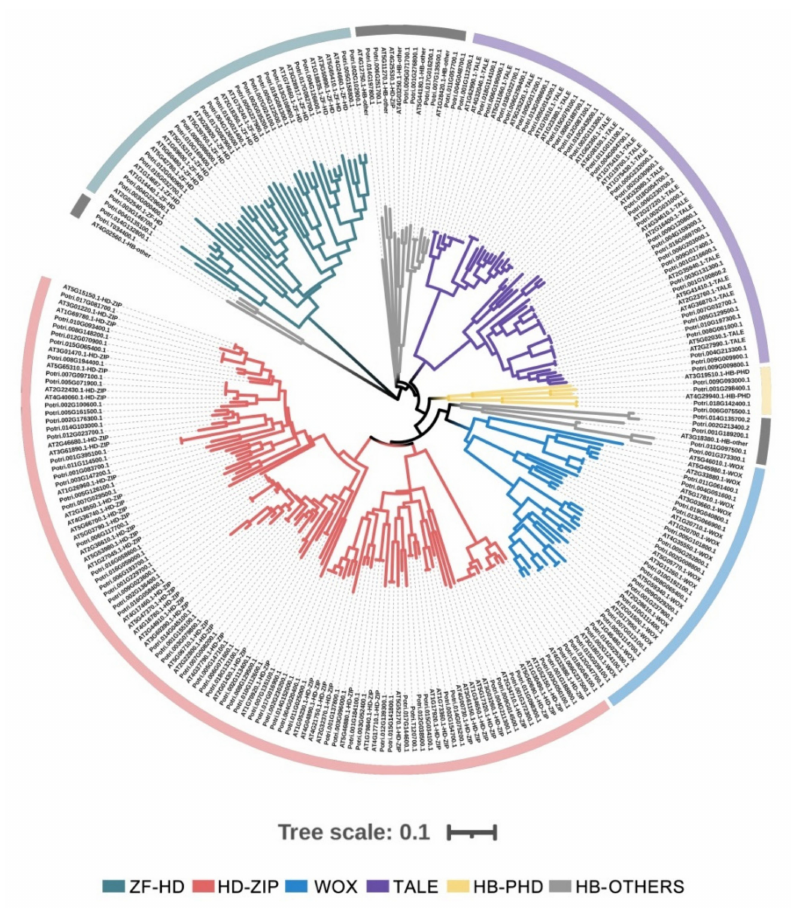
Figure 1. Maximum likelihood tree of the HB family from P. trichocarpa and Arabidopsis . The tree is divided into six subgroups, namely HD-ZIP, ZF-HD, HB-PHD, TALE, WOX and HB-OTHERS, which are indicated with different